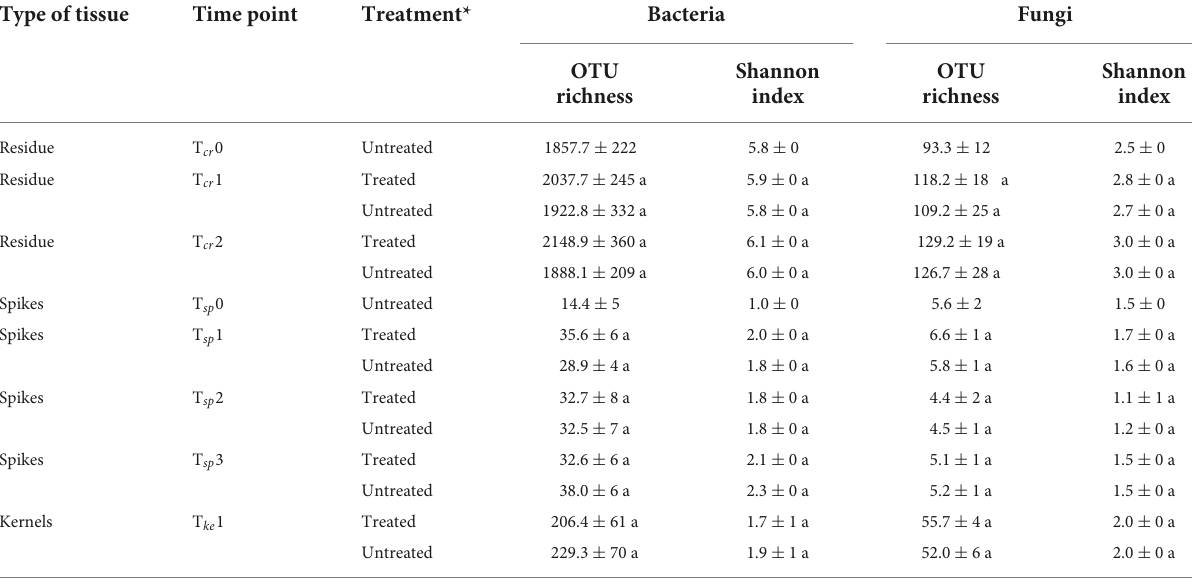
TABLE 3 The microbial richness (number of OTUs) and Shannon index of diversity for bacteria and fungi in crop residue, wheat spikes and kernel tissues collected at different time points under different T6085 treatments.